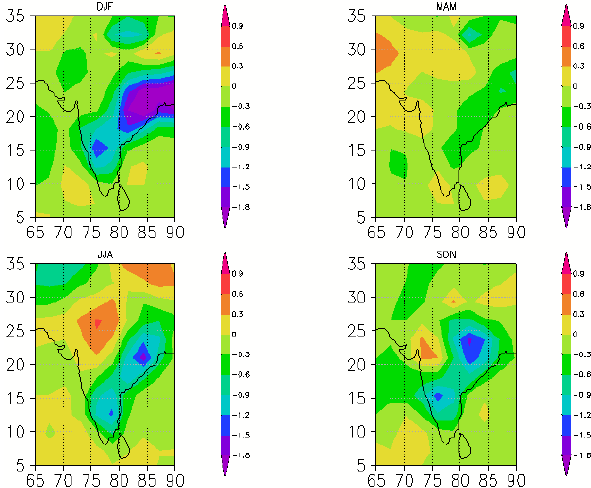
Figure 8. Seven-year seasonal 2m temperature anomalies (in K) in the MAIN_ACT simulation with GAINS emissions and aerosol